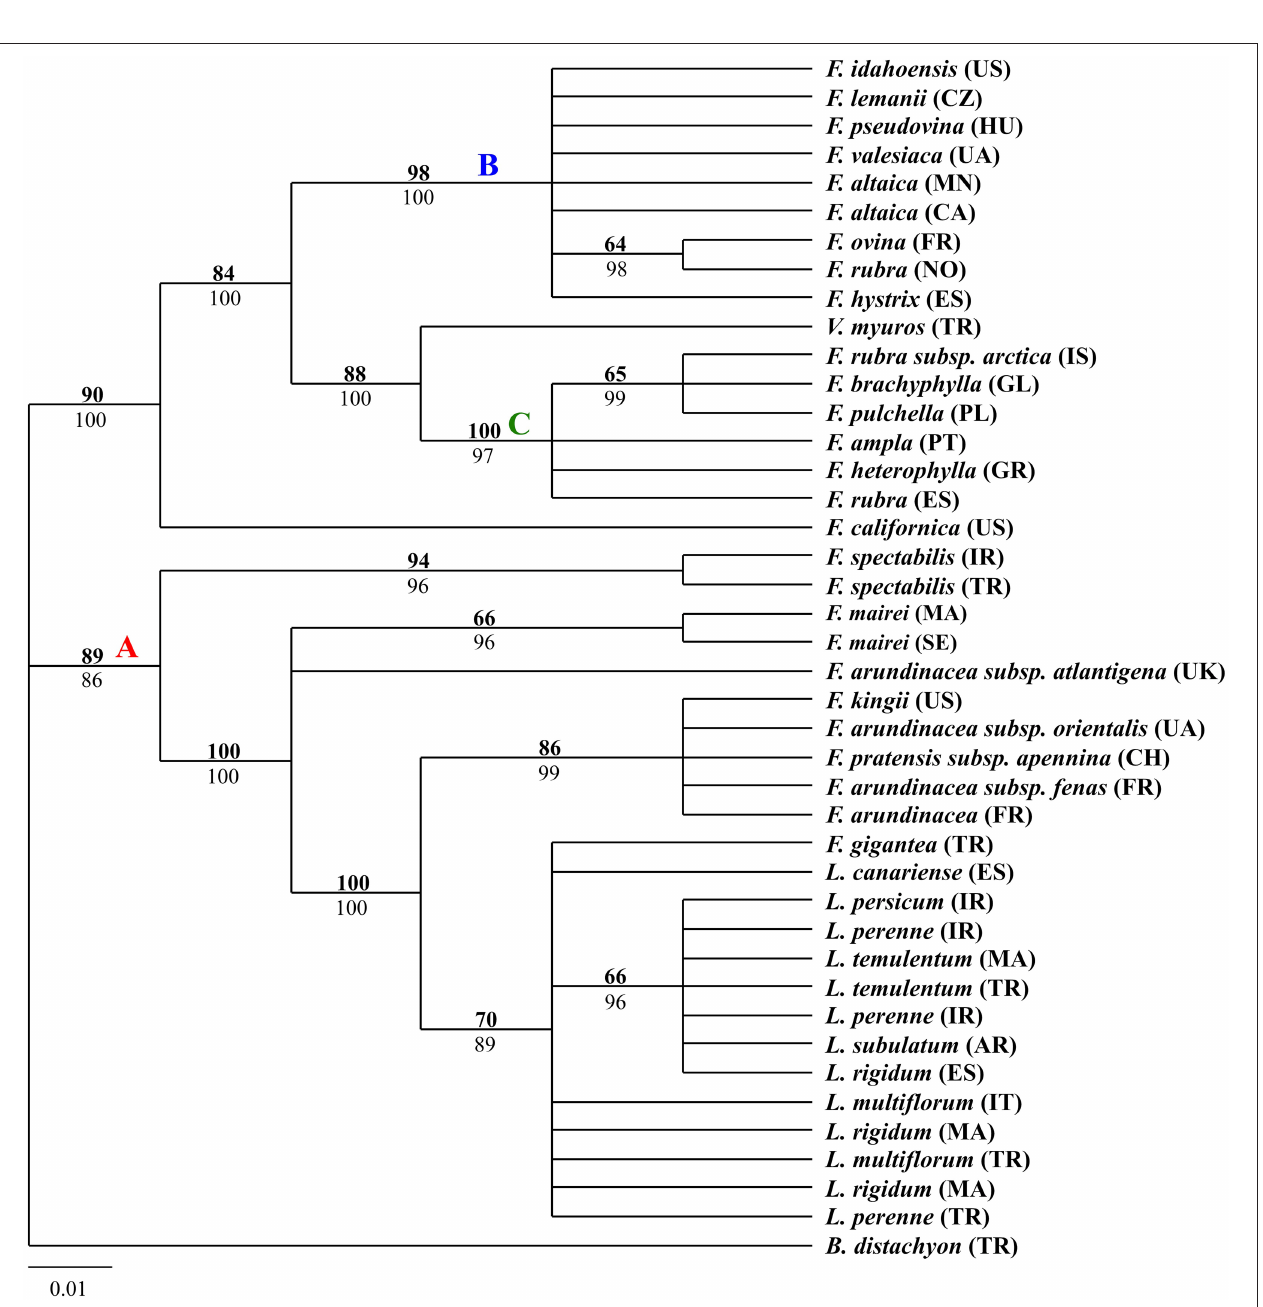
FIGURE 1 | Fifty-percent majority-rule BI tree inferred from the chloroplast non-coding intergenic spacers trnQ-rps16 sequences of Festuca / Lolium examplers. The number above and below the braches indicate boot strap values ≥ 50% and Bayesian posterior probability values ≥ 90%.